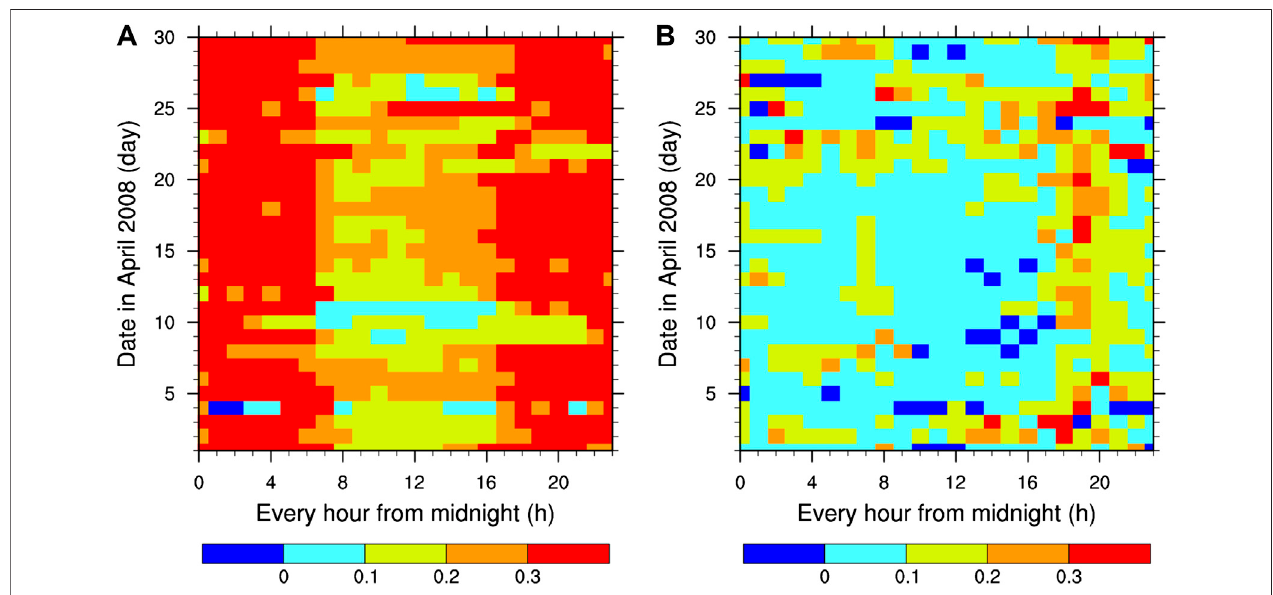
FIGURE 4 | The near-surface atmospheric stability of (A) observations and (B) simulations in the YSU scheme.